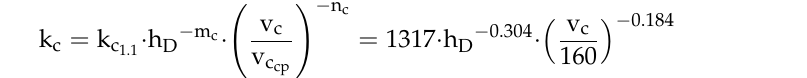
Table 7. Estimation for paired difference and test statistics.